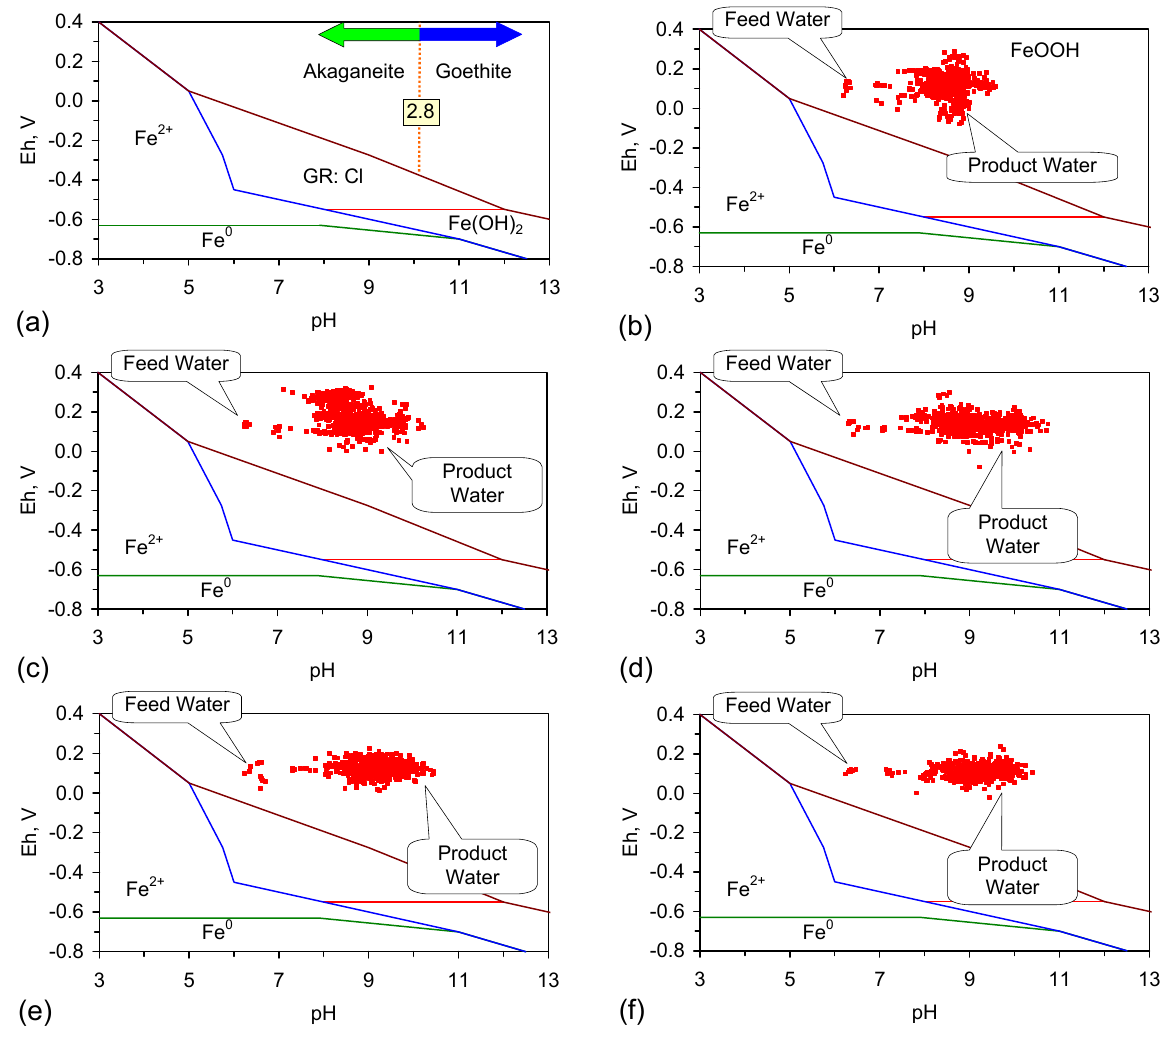
Figure 5. Eh vs. pH for the ST1 to ST5 series of ZVM TP trials (Figures C5–C9). ( a ) Pourbaix diagram identifying the dominant Fe species phase as a function of Eh and pH [19,69–75]. GR = green rust. 2.8 = 2.8 mgCl − ·L − 1 for R = 8; ( b ) ST1; ( c ) ST2; ( d ) ST3; ( e ) ST4; ( f ) ST5. Increasing the concentration of Cl − (salinity) increases the pH required